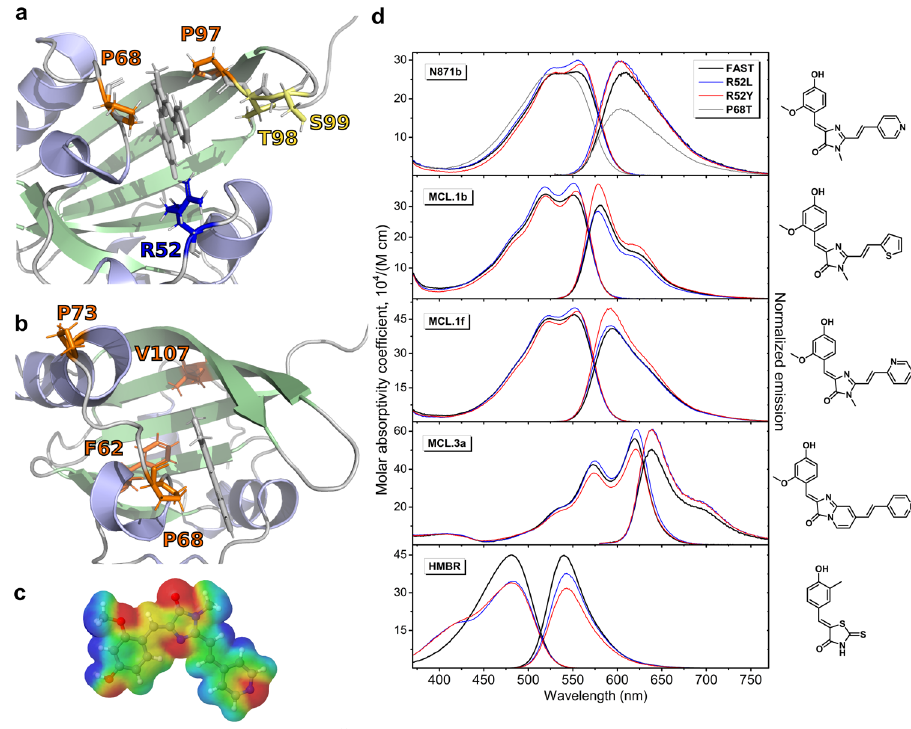
Fig. 2 Mutagenesis of FAST and absorption/emission spectra of brightest mutants. a Residues, rationally selected for mutagenesis in the current study as the closest to the pyridine moiety of N871b (shown with letters and numbers). b Residues that were mutated, because their substitutions proved favorable for other fl uorogens in the literature. c Electrostatic potential distribution over the contact surface of N871b according to DFT calculations. Red zones correspond to the negative potential, blue - to the positive one. d Absorption and emission spectra of various fl uorogens in complexes with FAST protein and its brightest mutants. Absorption spectra are normalized to the protein/ligand complex concentration and represented in the molar absorptivity coef fi cient scale. Emission spectra are normalized to the FQY.